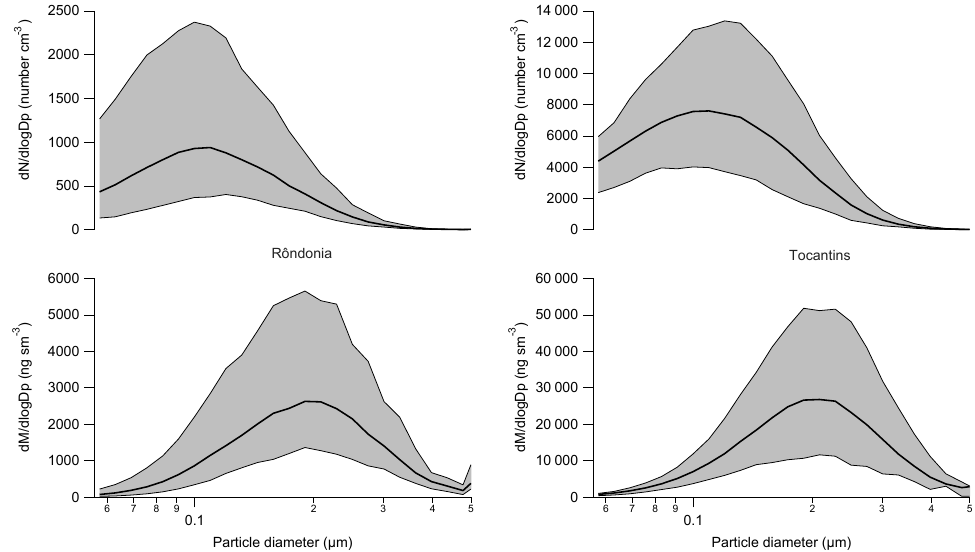
Figure 4. Black carbon number and mass size distributions for in-plume measurements of the Rondônia and Tocantins fires. The grey bound shading indicates the minimum and maximum size distributions from the plume intercepts on each flight, and the solid black line gives the average over all plume interceptions. Note the difference in scales between Rondônia and Tocantins size